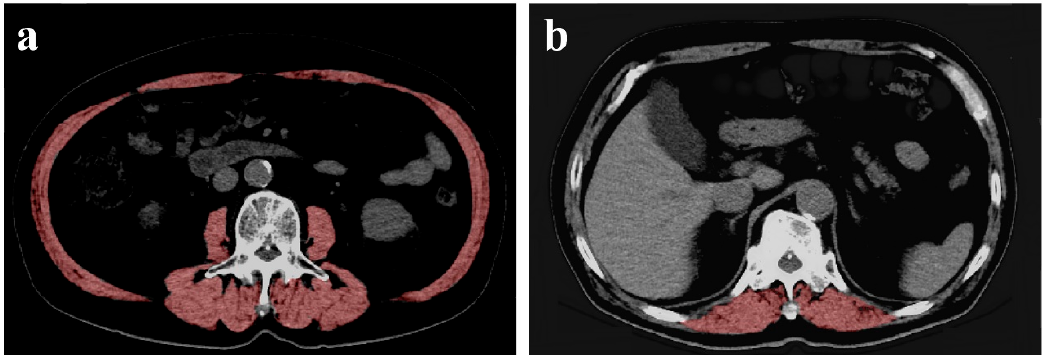
Figure 1. Example of L3 and Th12 delineation using ImageJ. ( A ) and ( B ) show the cross-sectional computed tomography (CT) images of L3 and Th12, respectively. The cross-sectional area of the muscle in the red area is